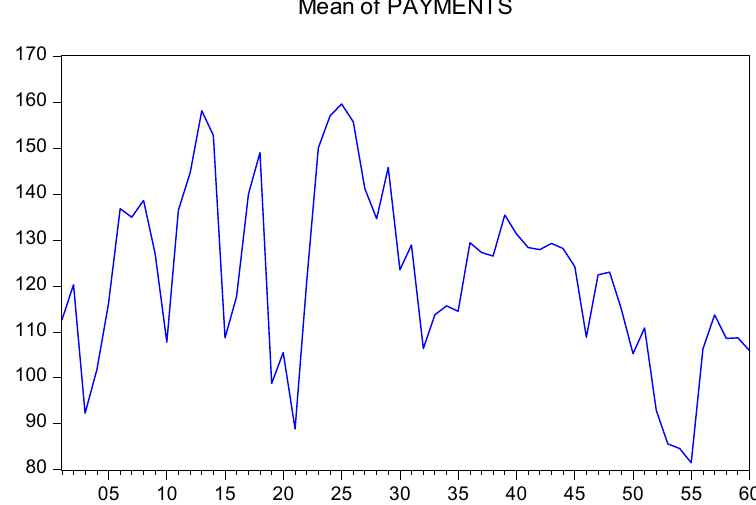
Figure 7. Mean tax payments, rounds 1 to 60, of all participants. Source: Own calculations.